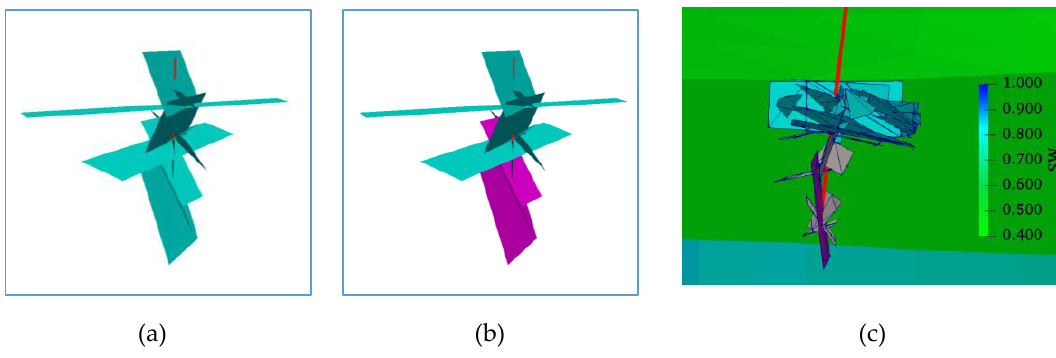
Figure 30. Shortest fracture paths from well B5 (vertical well) to the water contact: ( a ) initial shortest fracture paths; ( b ) bottom fractures planes (pink) in the shortest path; ( c ) Shortest fracture paths embedding the matrix blocks which display a vertical intersection plane view of the water saturation of the matrix.